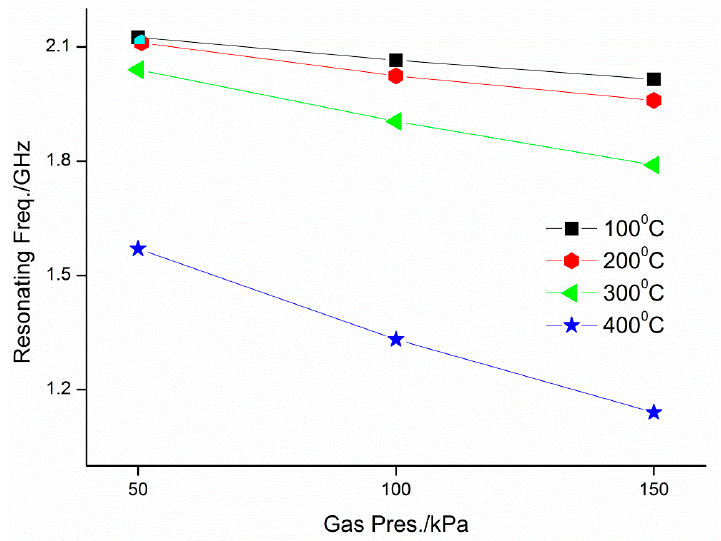
Figure 5. Measured resonant frequency of the developed sensor vs. the applied pressure at each temperature.